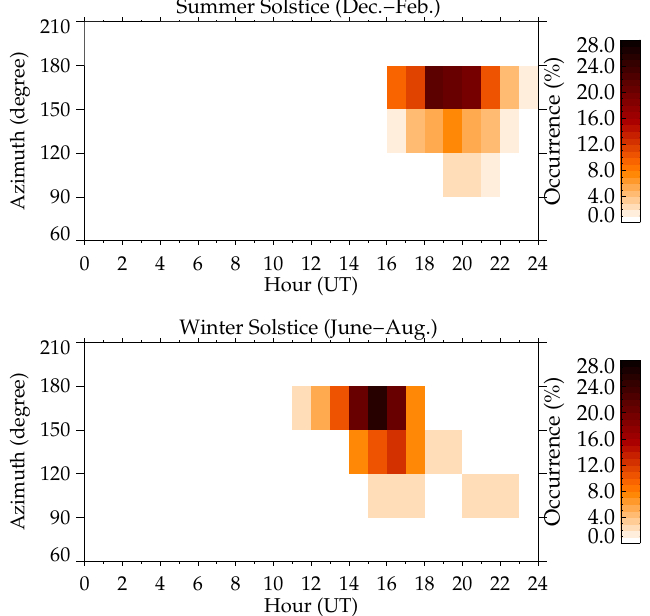
Figure 9. Time dependence of and seasonal variation in the occurrence of MSTIDs propagating southeastward over the South American equatorial region between January 2014 and December